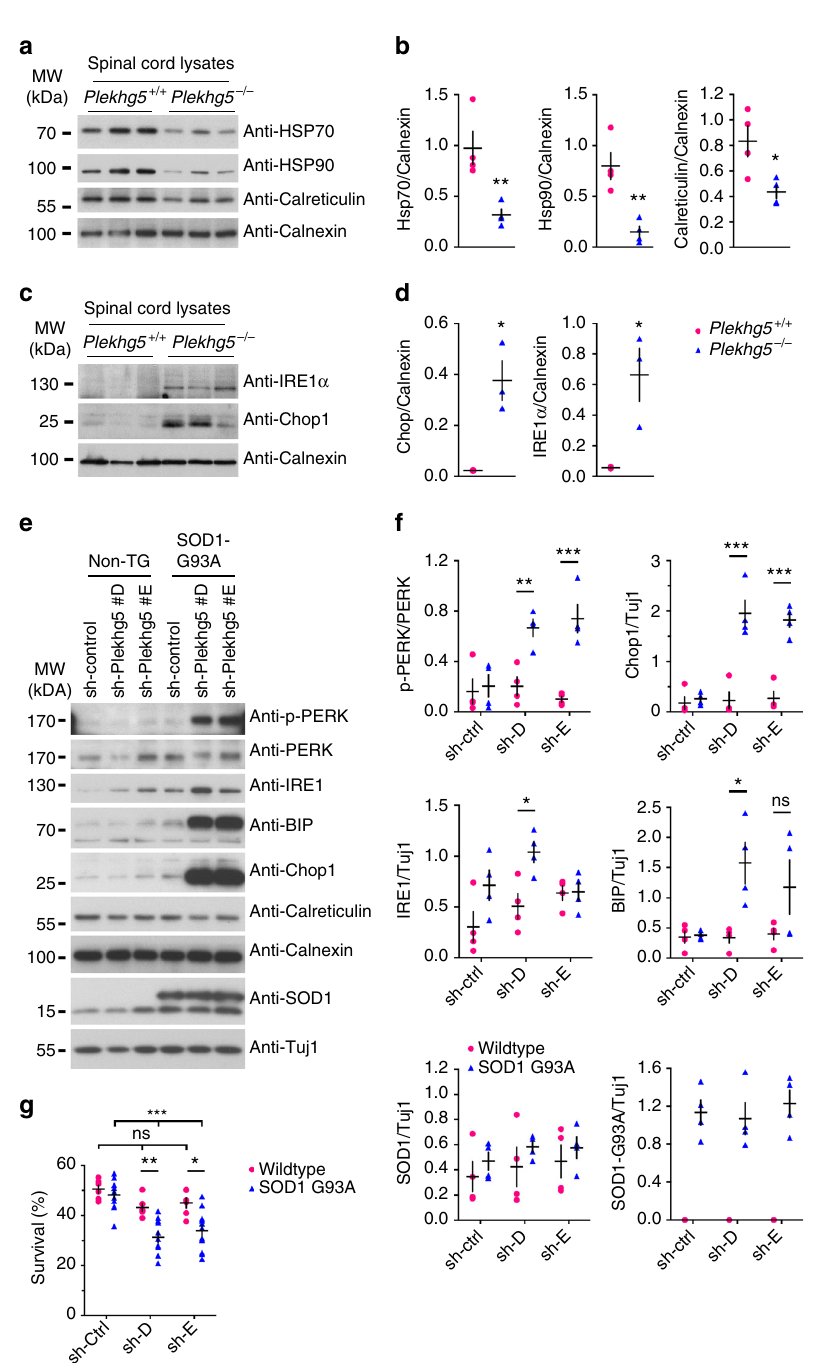
Fig. 9 Plekhg5 depletion in SOD1 G93A motoneurons results in elevated ER-stress. a Expression of HSP70, HSP90, Calreticulin, and Calnexin in spinal cord lysates from three animals per genotype. b Quanti fi cation of western blot shown in a (each data point represents expression levels of one animal; unpaired t -test; two-tailed). c Expression of IRE1 α and Chop1 in spinal cord lysates from three animals per genotype. d Quanti fi cation of western blot shown in c (each data point represents expression levels of one animal; unpaired t -test; two-tailed). e SOD1 G93A and non-transgenic motoneurons were depleted of Plekhg5 and several ER-stress markers were examined after 7 days in culture. f Quanti fi cation of western blots shown in e (each data point represents one individual experiment; mean ± SEM; unpaired t -test; two-tailed). g Survival of SOD1 G93A motoneurons decreased upon knockdown of Plekhg5 using two independent sh-RNA constructs (each data point represents the % of motoneuron-survival from one individual embryo. At least 50 motoneurons were evaluated from one embryo; mean ± SEM; two-way ANOVA; Bonferroni post-test). Images have been cropped for presentation. Full size images are presented in Supplementary Fig.